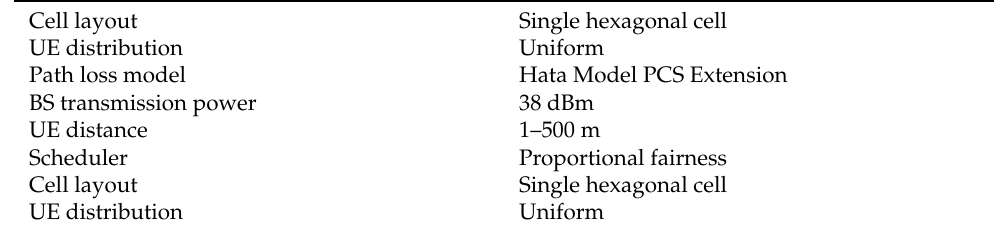
Figure 6. Network topology. Table 2. Cellular network configuration.